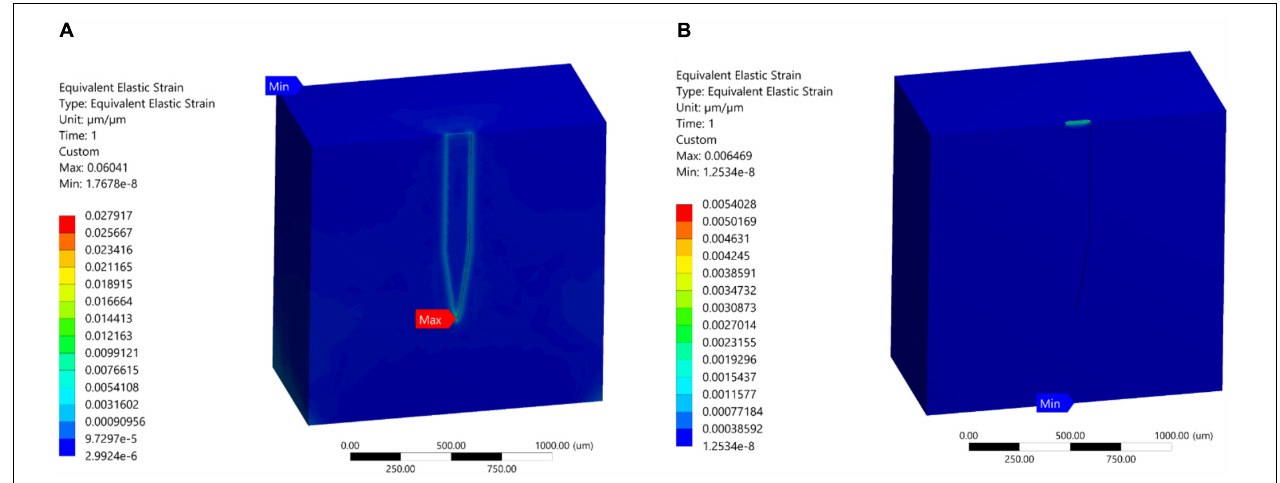
FIGURE 10 | Strain field distribution at probe surroundings tissue region. (A) Polyimide ( E = 2.7 GPa); (B) hypothetical soft material ( E = 6